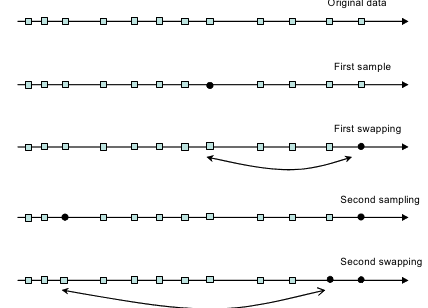
Figure 3. Random selection